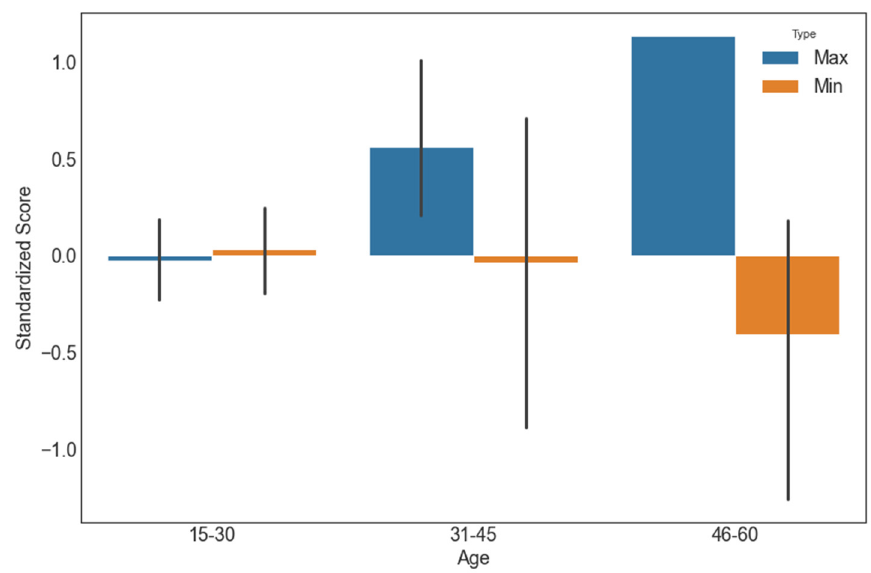
Figure 11. Standardized e-commerce awareness score distribution by age range for Reliability as- pect.